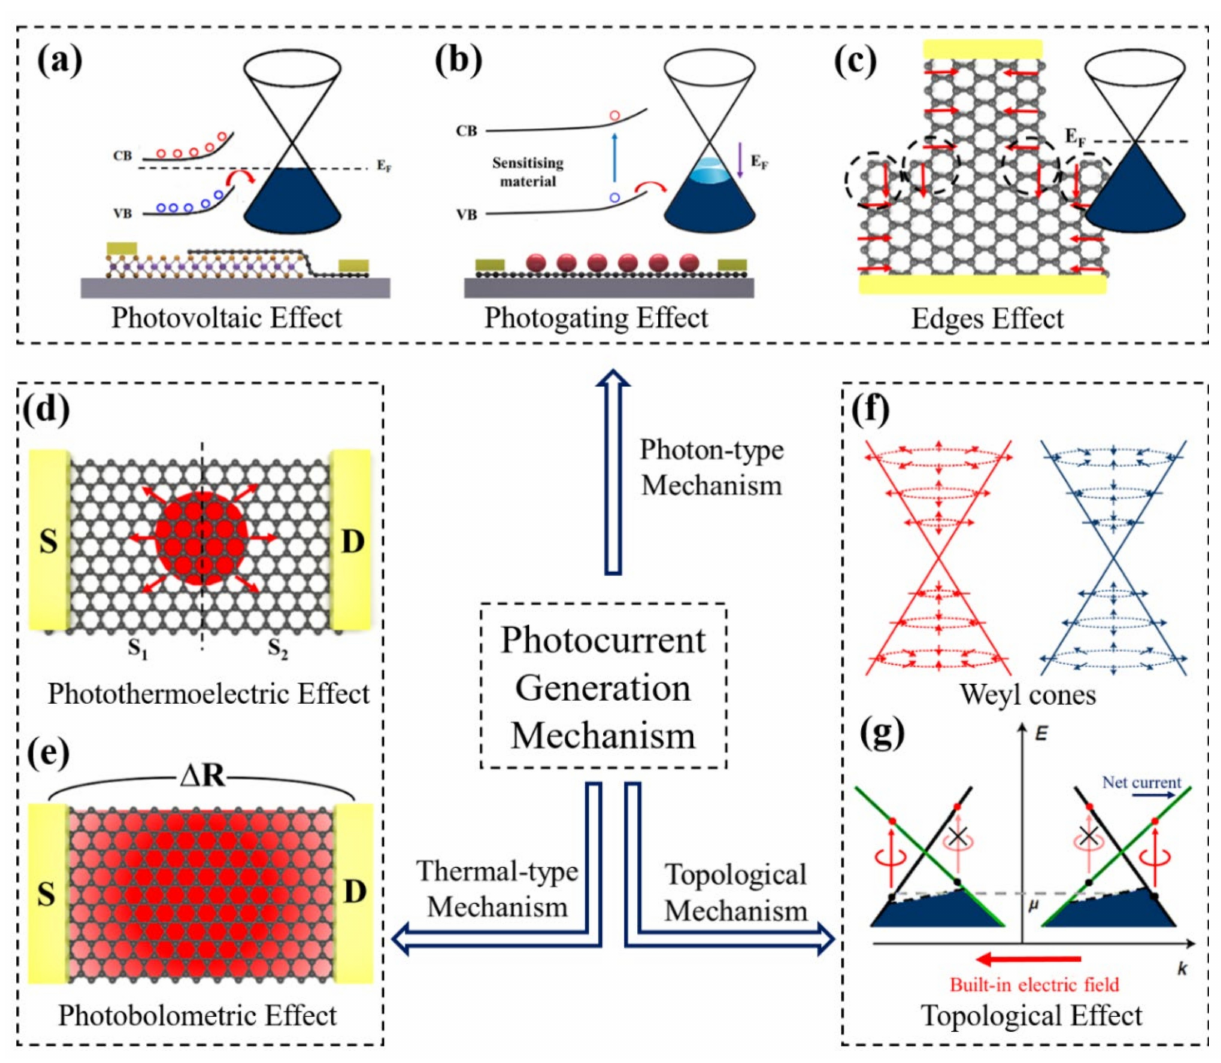
Figure 1. Photodetection mechanisms. ( a ) Photovoltaic effect. ( b ) Photogating effect. ( c ) Graphene Edges Effect. ( d ) Photothermoelectric effect. ( e ) Photobolometric Effect. ( f ) Sketch of a pair of Weyl cones. ( g ) Schematics of the chiral selection rule and circular photogalvanic effect response from a pair of Weyl cones in momentum space. The grey dashed line denotes the Fermi level µ without applying a built-in electric field. Black crosses mark the forbidden